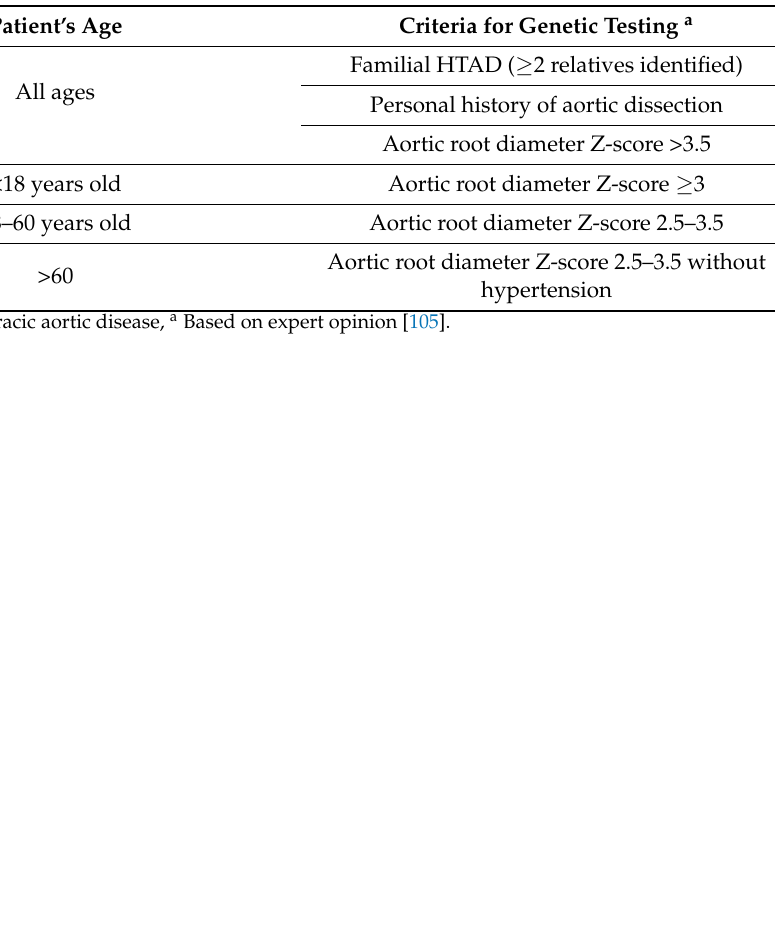
Table 1. Criteria for genetic testing in patients with suspected heritable thoracic aortic